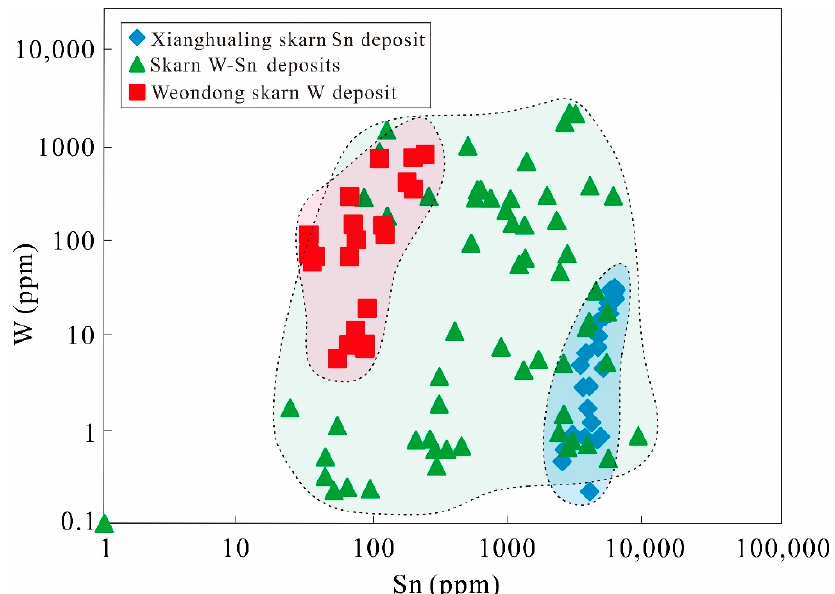
Figure 9. Binary plots of Sn vs. W concentrations of garnets from different deposits. Note: skarn W–Sn